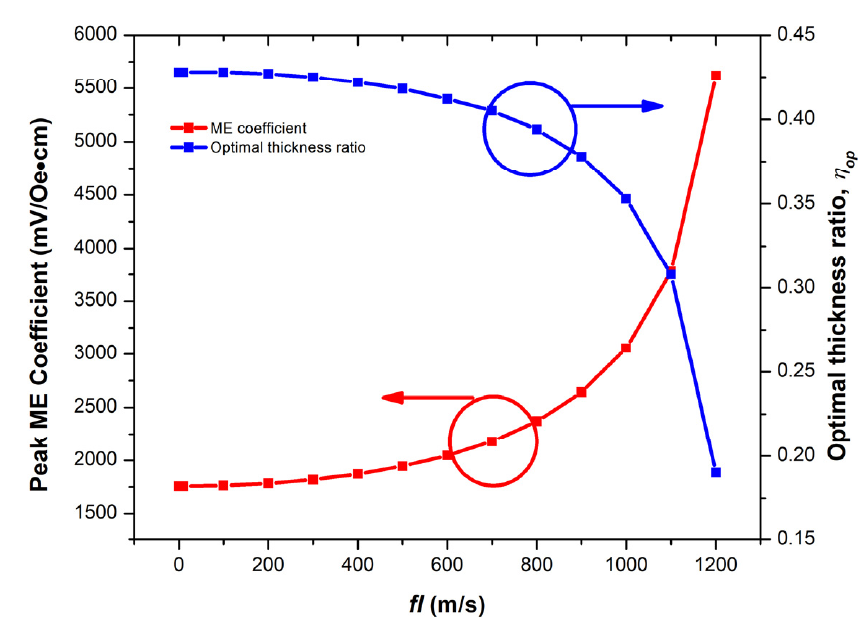
Figure 6. The peak ME coefficient and optimal thickness ratio as a function of fl [30].